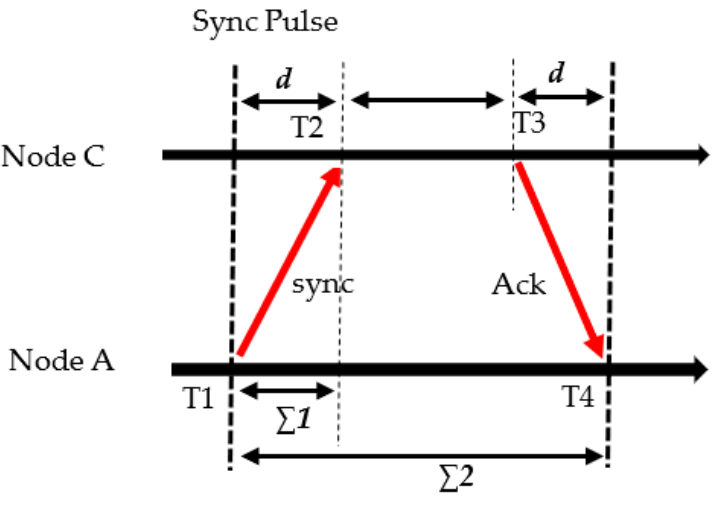
Figure 13. TPSN synchronization message.